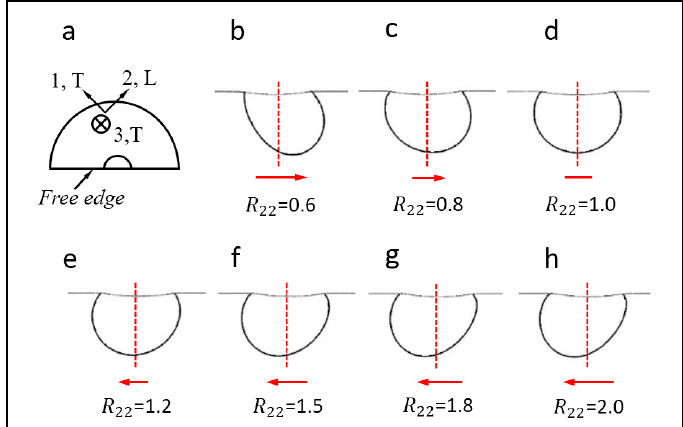
Figure 7. Influence of the R 22 value on the shape of the out-of-plane deformation